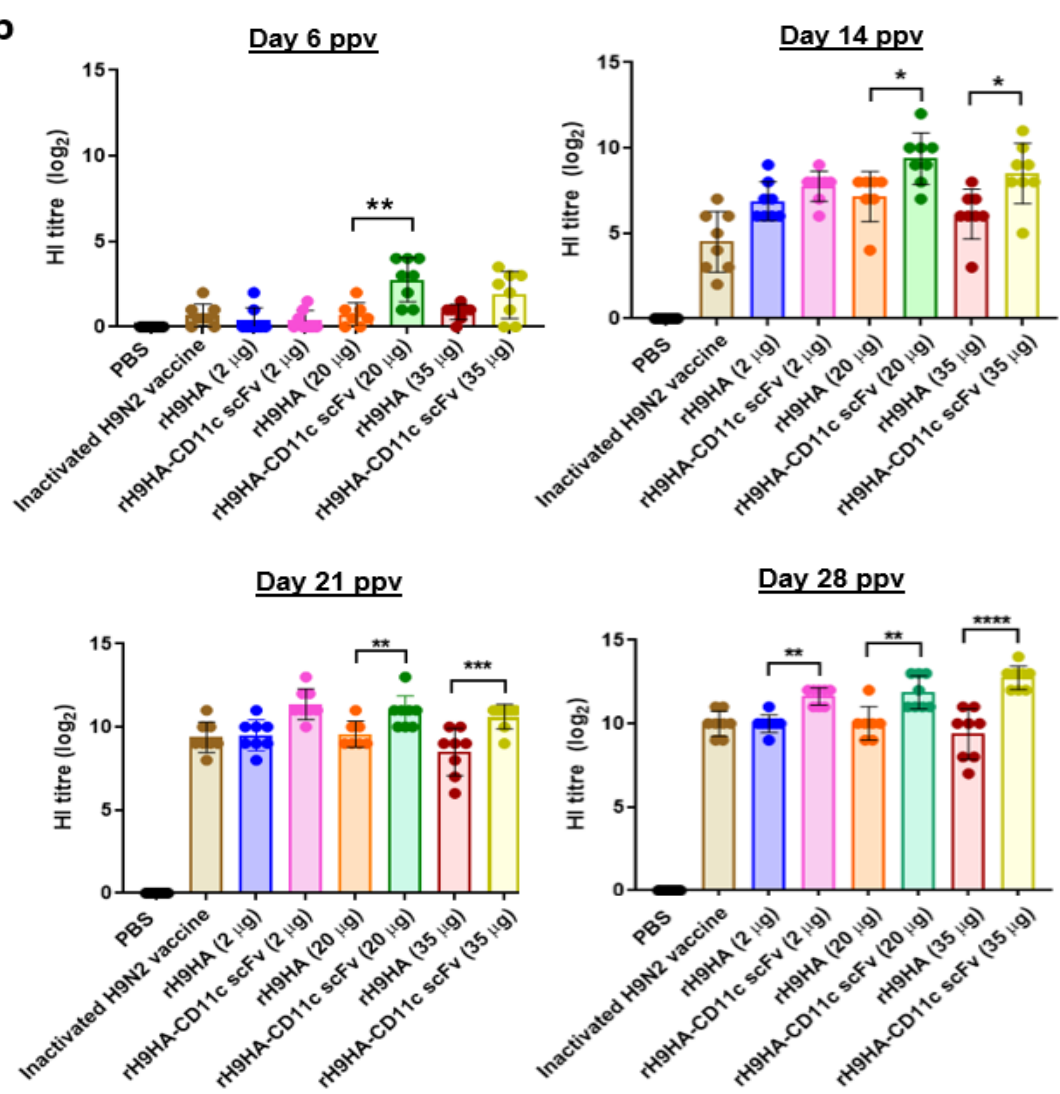
Figure 6. Analysis of HI antibodies in the serum of vaccinated chickens. ( a ) HI antibody titres in chickens vaccinated with rH9HA, rH9HA-Dec205 scFv, and inactivated H9N2 vaccine. ( b ) HI antibody titres in chickens vaccinated with rH9HA, rH9HA-CD11c scFv, and inactivated H9N2 vaccine. Groups of 7-day-old chickens (n = 8 per group) were immunised with 2.8, 28, and 49 µ g of rH9HA-Dec205/CD11c scFv equivalent to 2, 20, and 35 µ g of rH9HA (equimolar concentration). Boost vaccination was given on day 7 post primary vaccination. The chickens were bled on day 6, 14, 21, and 28 post primary vaccination (ppv). The highest dilution of serum inhibiting the agglutination of chicken RBCs by H9N2 virus (UDL 01/08) was recorded. Data are presented as mean ± SD and analysed by one-way ANOVA followed by Tukey’s multiple comparison test. **** p < 0.0001, *** p < 0.001, ** p < 0.01, * p < 0.05.